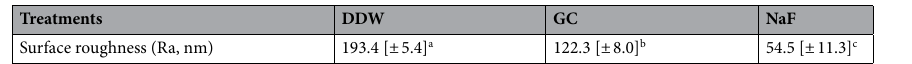
Table 2. The average surface roughness (Ra) of enamel blocks after pH cycling (Mean [± SD]). Different superscript letters indicate a significant difference between groups (p < 0.05). DDW samples treated